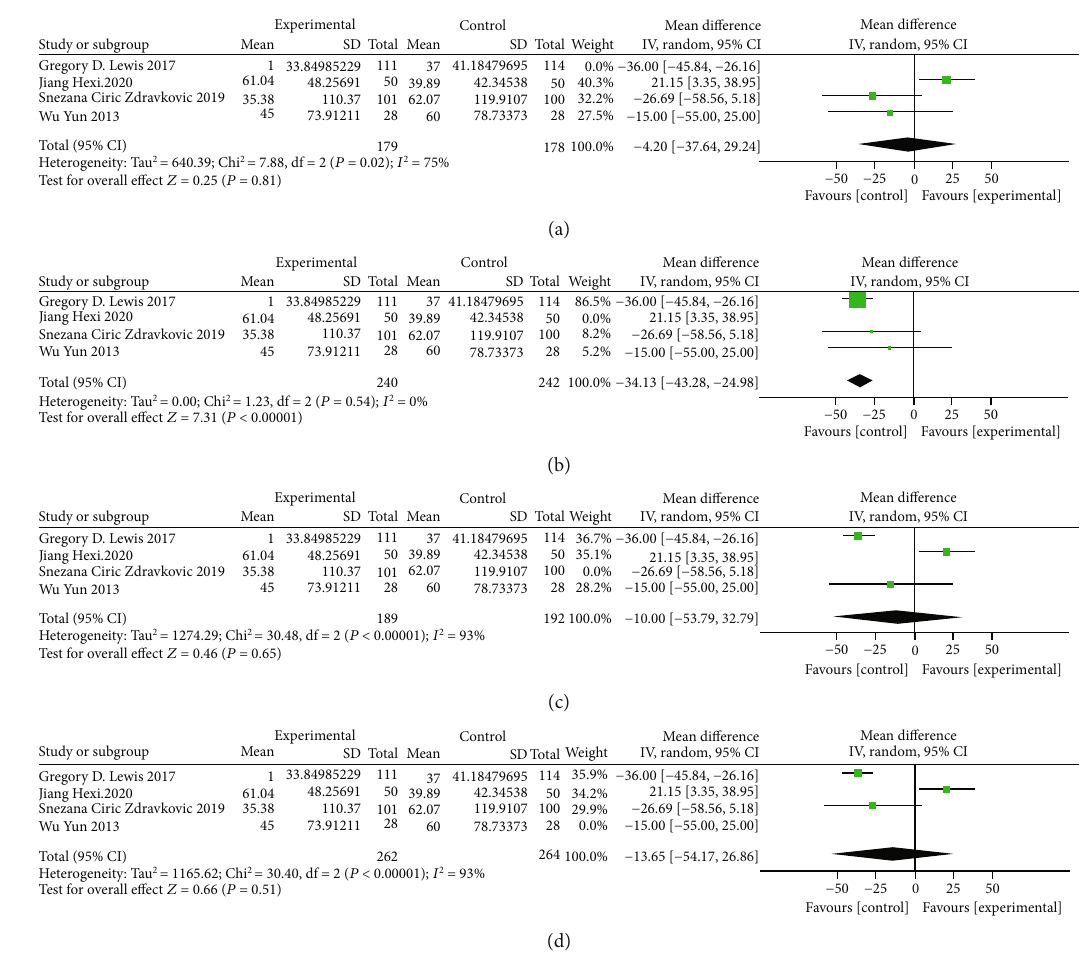
Figure 6: Sensitivity analysis of 6-minute walk